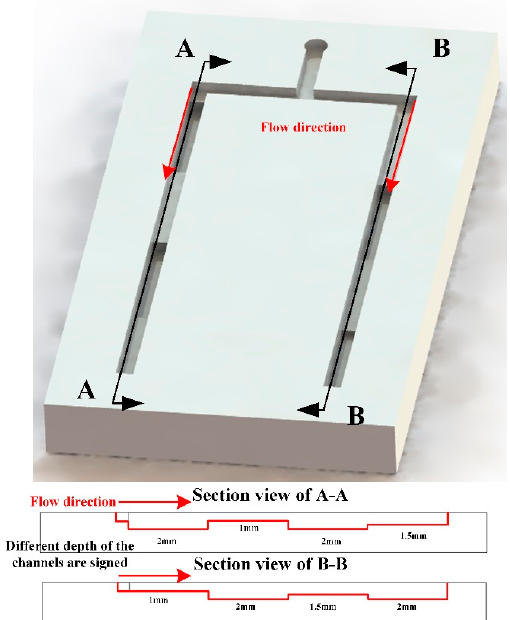
Figure 7. Flow speed control in 3D channels. The left channel and the right channel all have four